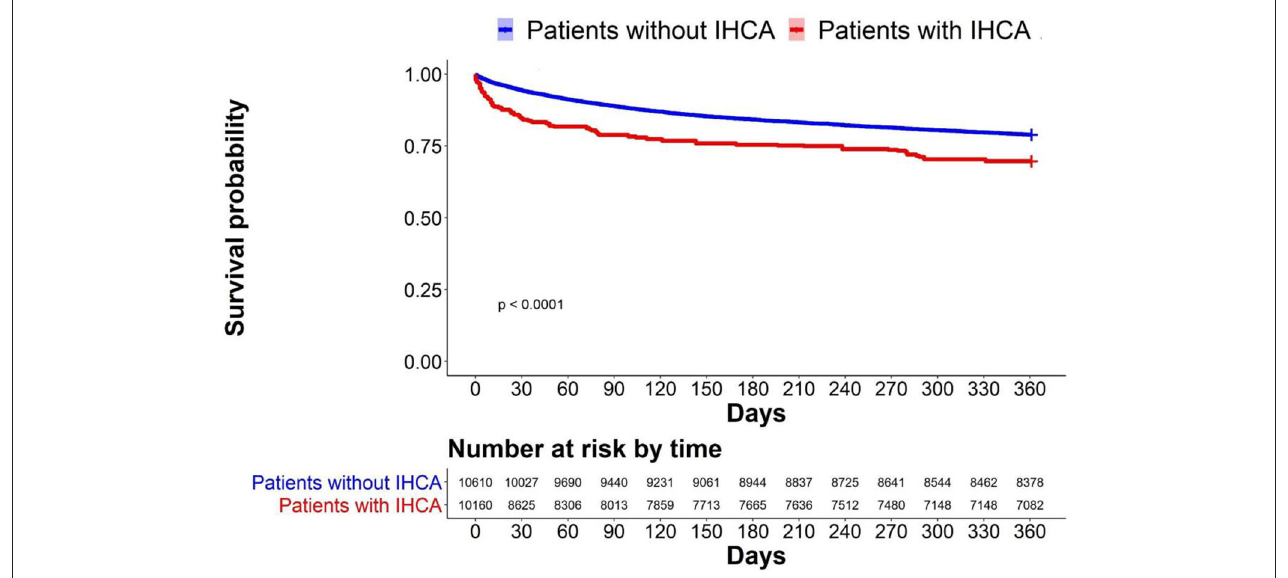
FIGURE 4 | Survival probability after PS weighting.The Kaplan-Meier survival curve showed the impact of IHCA on survival probability.